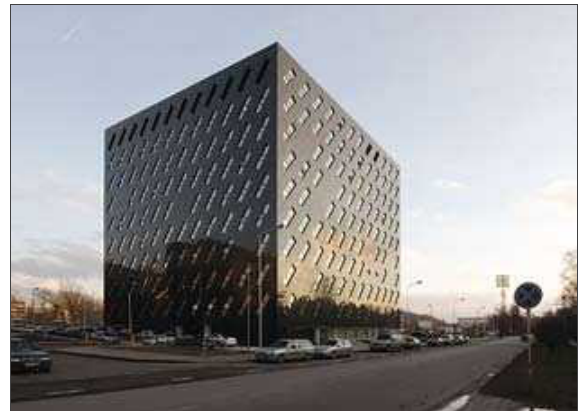
2008 m. Fig. 7. Prosecutor's Office building,